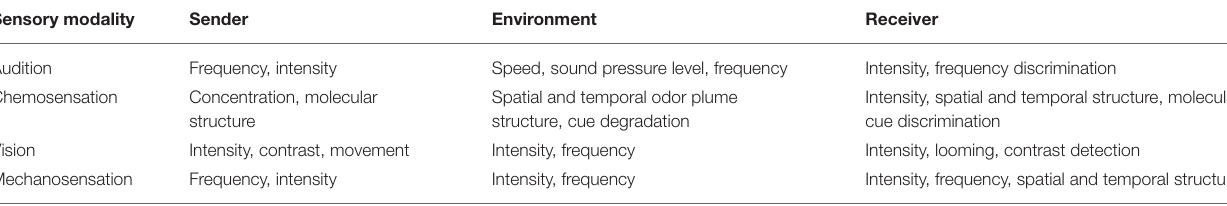
The second column gives relevant properties of the stimulus produced by the sender, the third column lists properties that are changed during transmission, whereas the last column shows the cue properties used by the receiver to extract information. Masking occurs when the environment modulates the cue so that it can no longer be discerned against